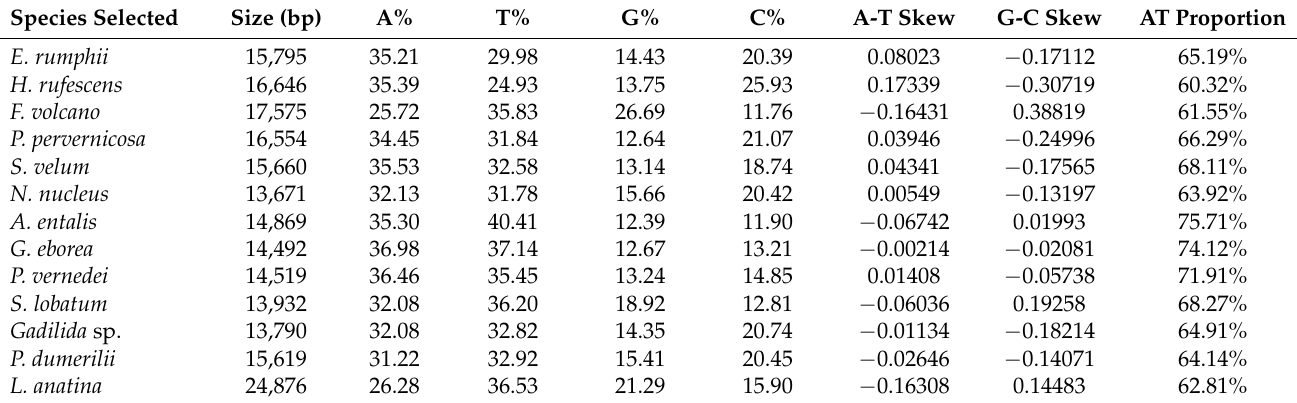
Table 3. Statistics of nucleotide composition in selected molluscan